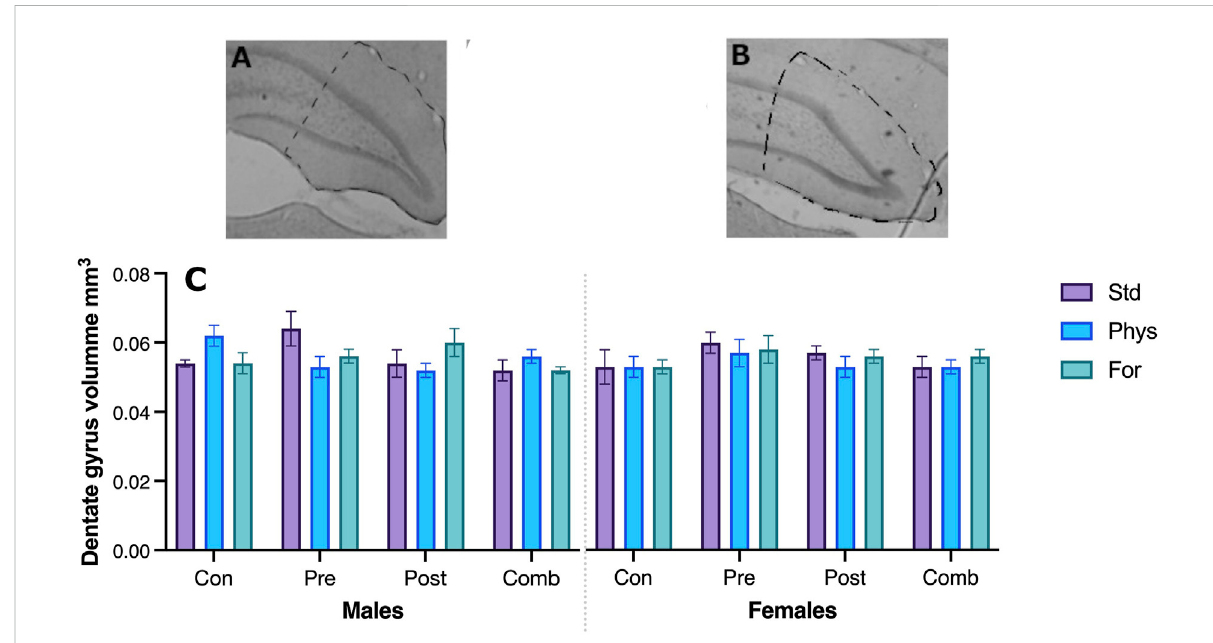
FIGURE 9 Hippocampus dentate gyrus in a typical control (A) and ELS (B) subject. The volume of the hippocampus was not statistically different between the groups (C)